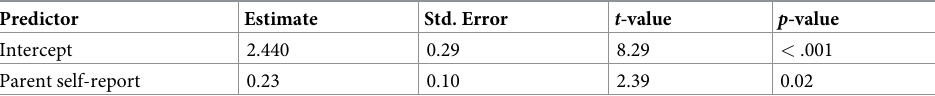
Table 10. Results from linear regression predicting adolescents’ mean stereotyping scores as a function of their parents’ scores. Predictor